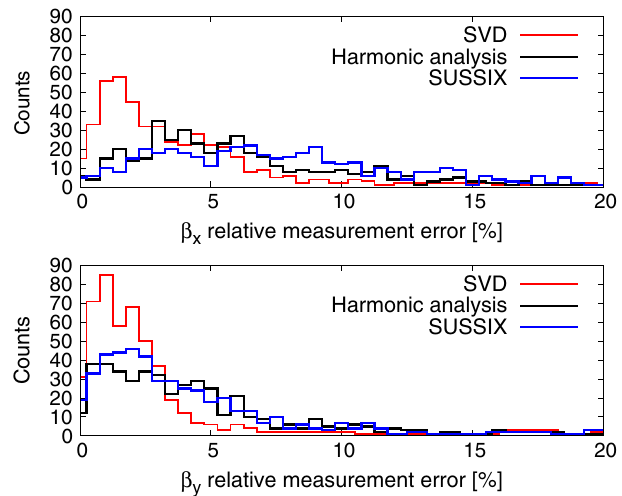
FIG. 2. (Color) Comparison of the resulting measurement errors for the three algorithms used to reconstruct the (cid:2) functions. Histograms of the horizontal and vertical beta function relative measurement errors are shown on the top and bottom plots,